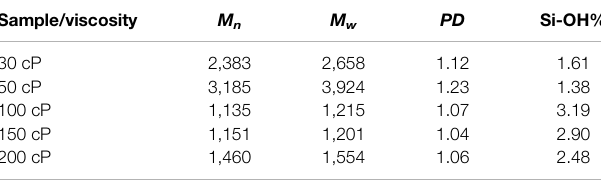
TABLE 2 | M n , M w , and PD of silicone oils with different viscosities.